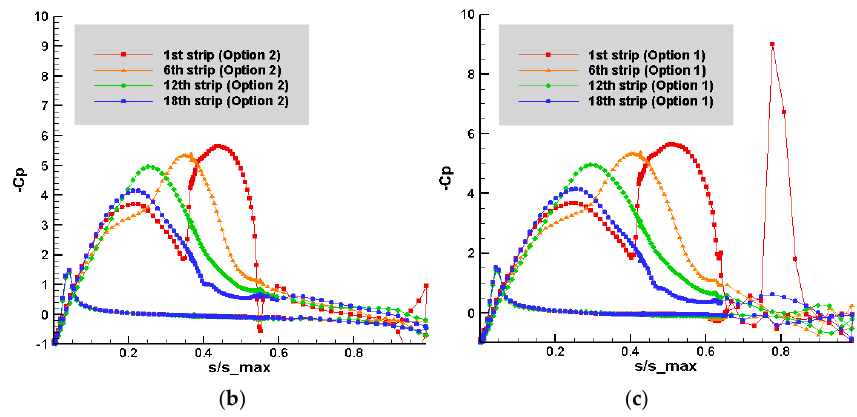
Figure 19. Description of the strips that are adopted for the pressure plotting on the duct ( a ) and the corresponding pressure distributions on each strip using the present method with Option 2 ( b ) and Option 1 ( c ).